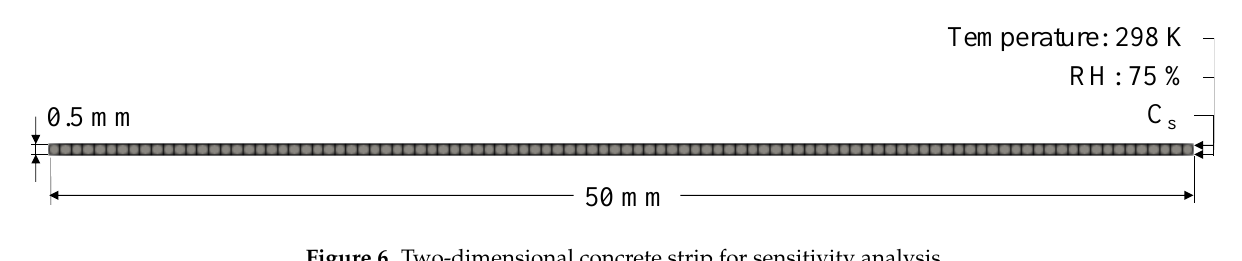
Figure 6. Two-dimensional concrete strip for sensitivity analysis. Table 3. List of parameters and their values for sensitivity analysis.